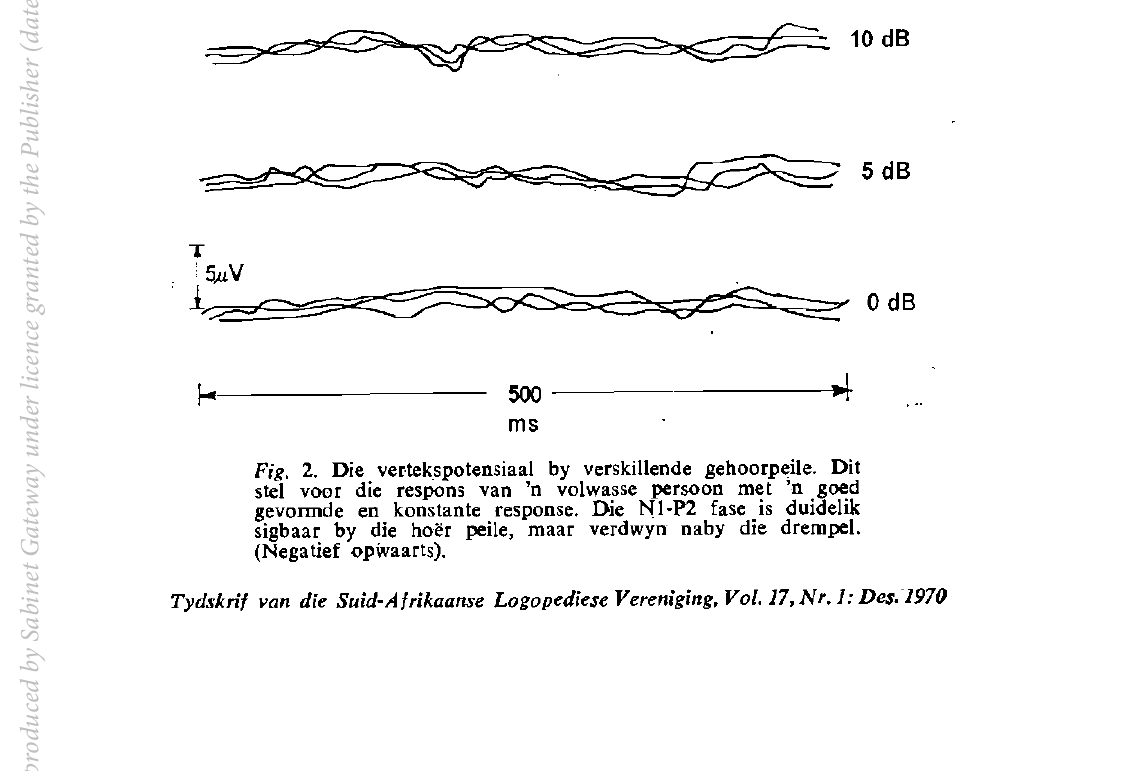
Fig. 2. Die vertekspotensiaal by verskillende gehoorpeile. Dit stel voor die respons van 'n volwasse persoon met 'n goed gevormde en konstante response. Die N1-P2 fase is duidelik sigbaar by die hoer peile, maar verdwyn naby die drempel. (Negatief opwaarts). Tydskrif van die Suid-Afrikaanse Logopediese Vereniging, Vol. , Nr. 1: